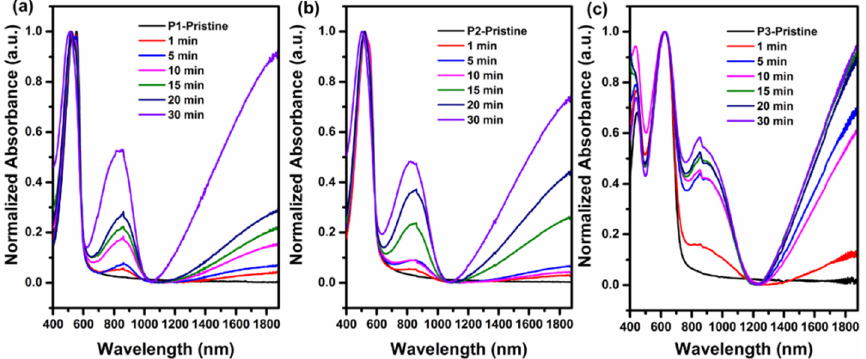
Figure 4. Time dependence of normalized UV–vis–NIR absorption spectra of polymer films doped with FeCl 3 : P1 ( a ), P2 ( b ), and P3 ( c ).